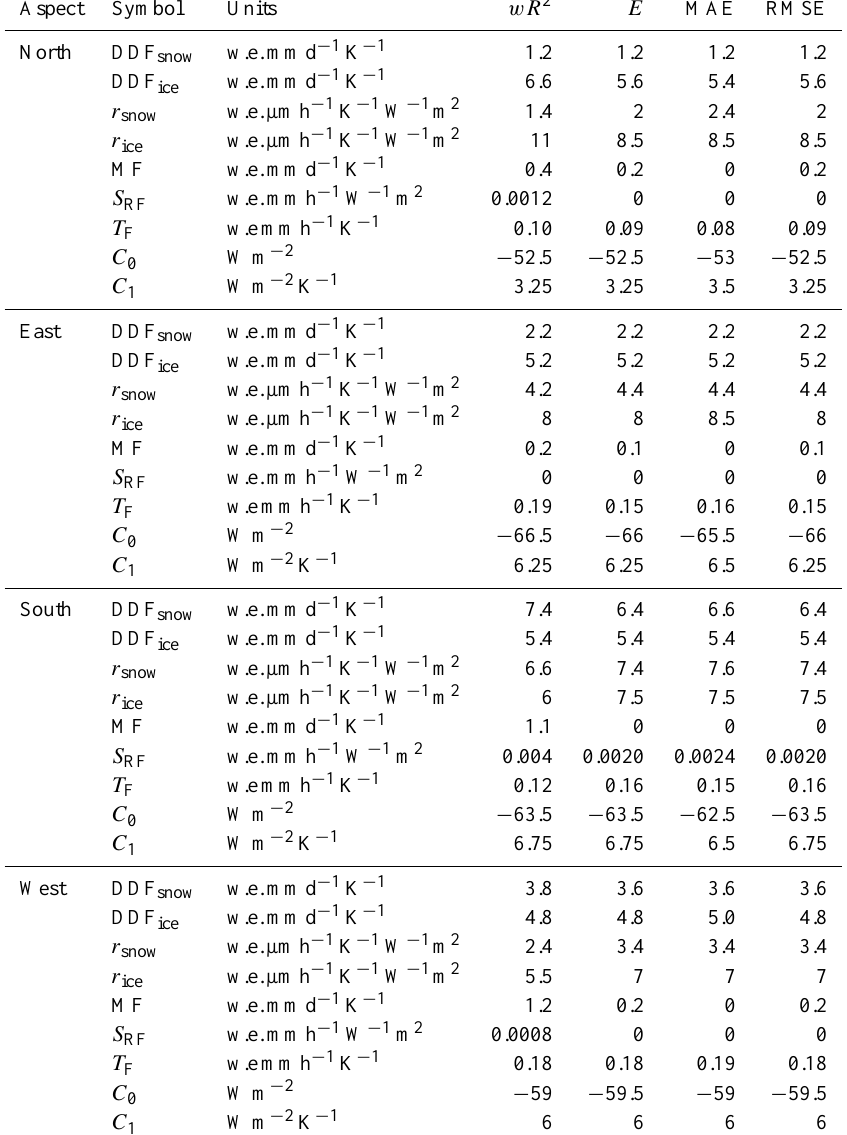
Table 5. Best fit parameters for CTIM, HTIM, PTIM and SEBM found by optimizing slope weighted coefficient of determination ( wR 2 ), Nash-Sutcliffe efficiency criterion ( E ), mean absolute error (MAE), and root mean square error (RMSE) with respect to cumulative melt simulated with the IEBM for synthetic glaciers oriented in the four cardinal